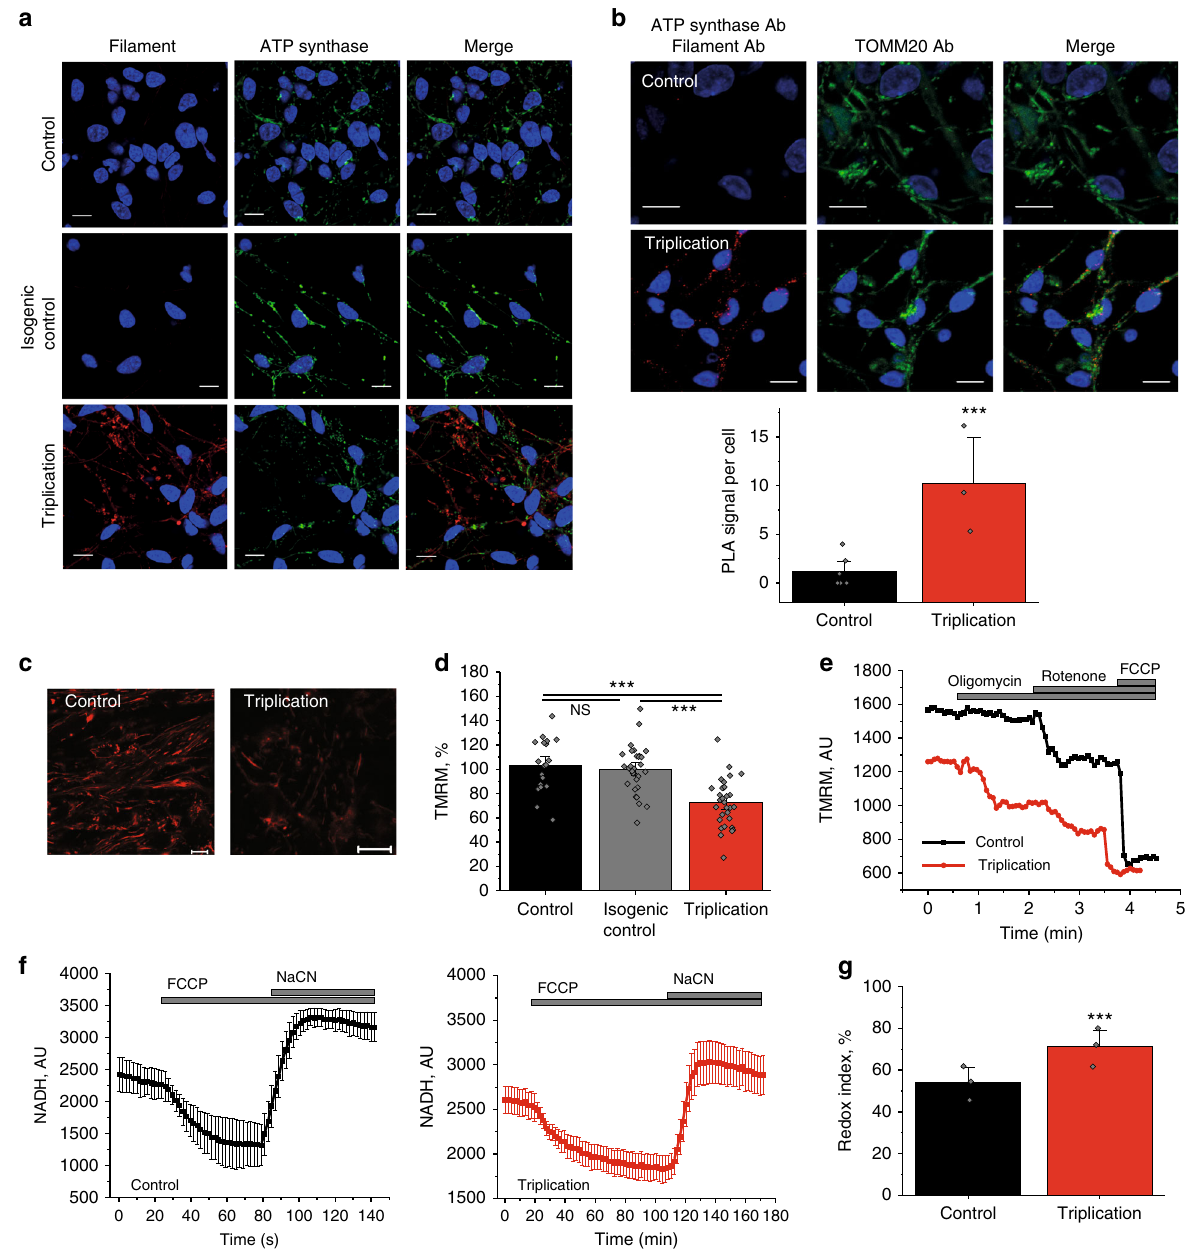
Fig. 5 Impaired mitochondrial function in SNCA triplication iPS derived neurons. a Representative ICC images of control, isogenic control, and triplication cells probed for fi lament α -synuclein. The nucleus can be seen in blue (DAPI). b Representative PLA images and quanti fi cation of control and triplication iPS derived neurons showing a close proximity between fi lament α -synuclein and ATP synthase with the nucleus in blue (DAPI). TOMM20 was probed for to validate the mitochondrial localisation of the PLA signal. N = 3 experiments; control n = 155 cells, and triplication n = 115 cells. c Representative images of control and triplication iPS derived neurons loaded with TMRM and d ΔΨ m quanti fi cation. N = 3 experiments, n ≥ 32 cells. e Representative traces of TMRM fl uorescence in control and SNCA triplication neurons after addition of oligomycin (2 μ g/ml), rotenone (1 μ M), and FCCP (1 μ M). f Representative trace of NADH in control and triplication iPS derived neurons. FCCP is applied to maximise respiration and therefore minimise the NADH pool and NaCN is added to block the mitochondrial respiration and therefore maximise the NADH pool. g Quanti fi cation of the redox index in control ( N = 3 experiments, n = 112 cells) and triplication iPS derived neurons ( N = 3 experiments, n = 148 cells). Two-tailed Student ’ s t -test for b , d , g . b Scatter points on scatter column represent number of puncta per cell. d , g Scatter points represent individual cells/areas. Data represented as mean ± SEM. * p < 0.05; ** p < 0.01; *** p <